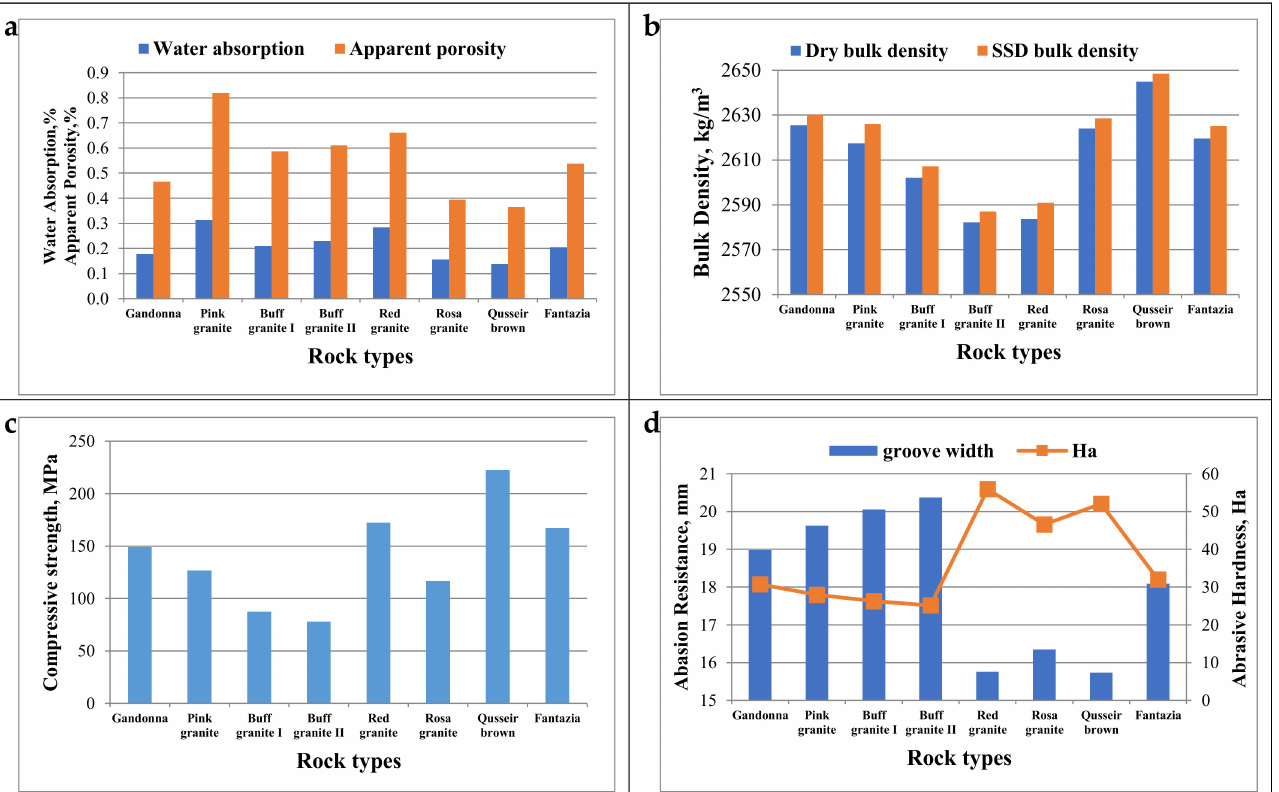
Figure 11. Physico-mechanical properties of different granitic rock types. ( a ) water absorption and porosity; ( b ) dry and saturated surface dry (SSD) bulk density; ( c ) compressive strength; ( d ) abrasion